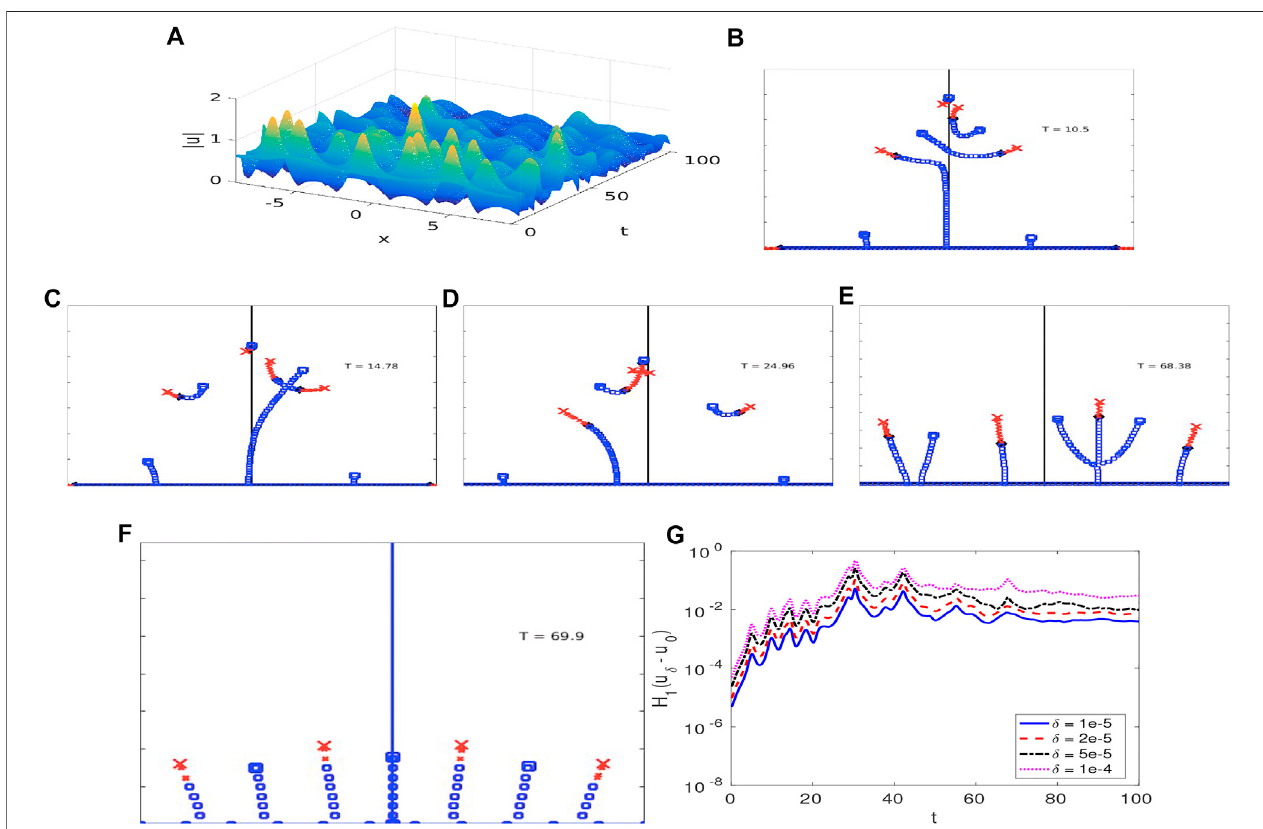
(cid:12)(cid:12)(cid:12)(cid:12)(cid:12) (cid:12)(cid:12)(cid:12)(cid:12)(cid:12) U ( 2 , 3 ) ε , c ( x , t ) and Spectrum at (B) t (cid:1) 10 . 5, (C) t (cid:1) 14 . 78, (D) t (cid:1) 24 . 96, (E) t (cid:1) 68 . 38, (F) t (cid:1) 69 . 9, and (G) η ( t ) for f 1 ( x , t ) ,